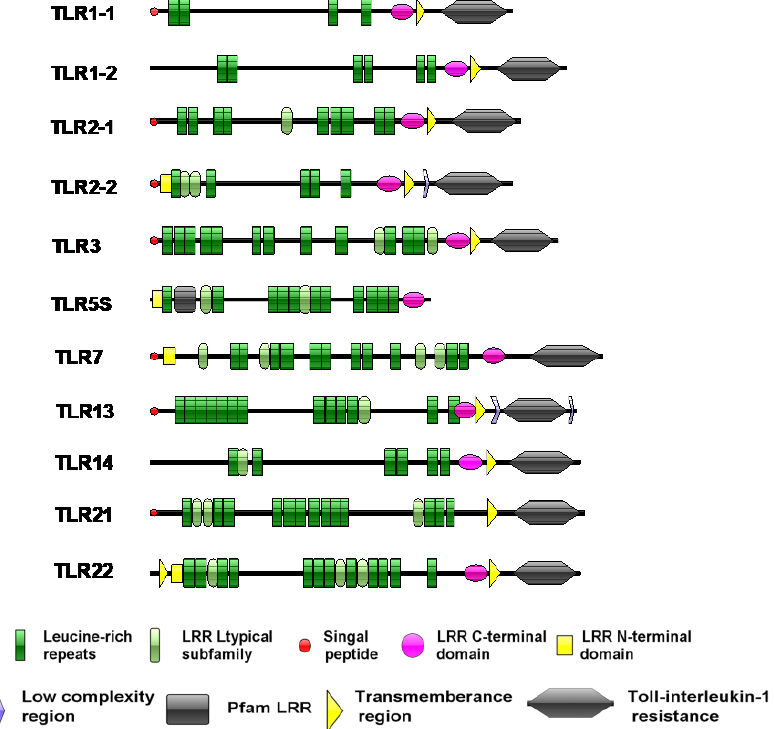
Figure 4. The structure features prediction of TLRs in marbled rockfish. Green hexagonals represent TIR; green bars represent LRRs; blue bars represent transmembrane region (TM); red bars represent signal peptide.